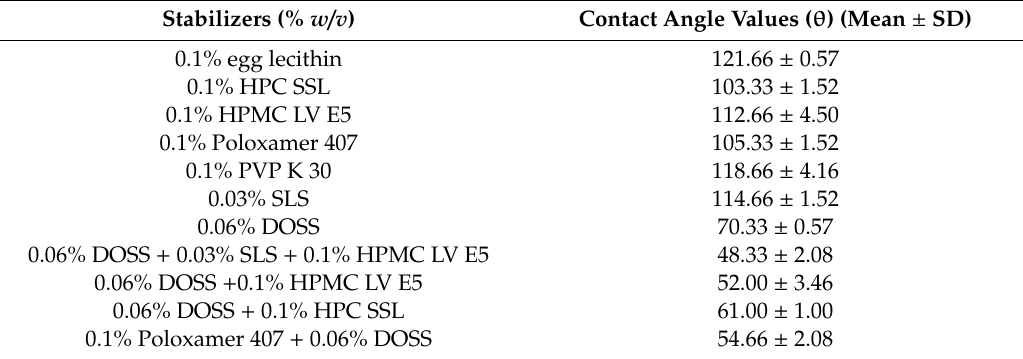
Figure 5. A representative image showing overlay of characteristic peaks at 2 θ 16.1 ◦ ± 0.2 for (1) the physical mixture of CEL_MAN_SLS (30:67.5:2.5) and (2) CEL_NCSD. Table 2. Contact angle values of various stabilizer solutions with CEL (the values are the average of three